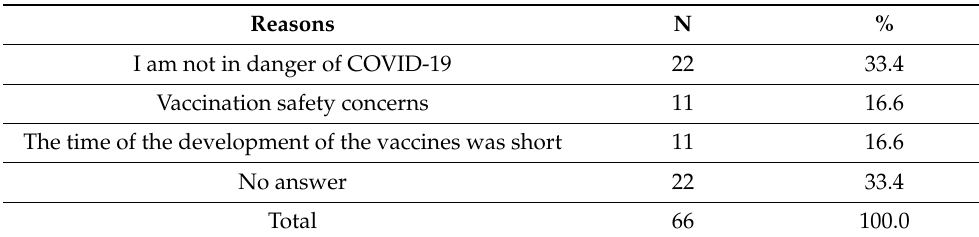
Table 2. Stated reasons for not getting vaccinated for COVID-19.